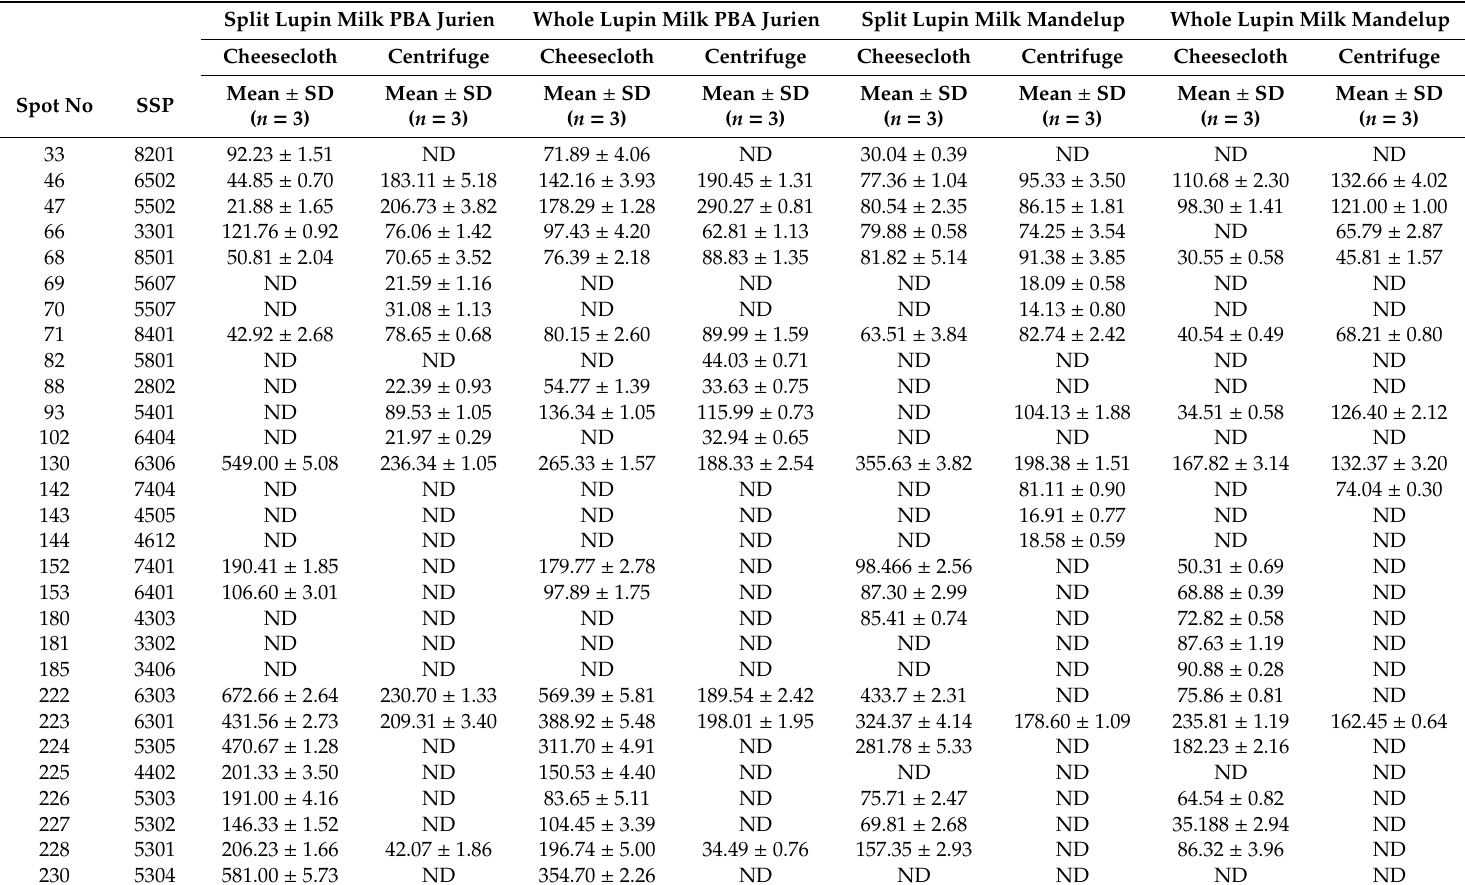
Note: Protein spots with abundance di ff erences between di ff erent samples are listed in this table. SSP = standard spot number; SD = standard deviation; Number of replicates ( n = 3); ND = not